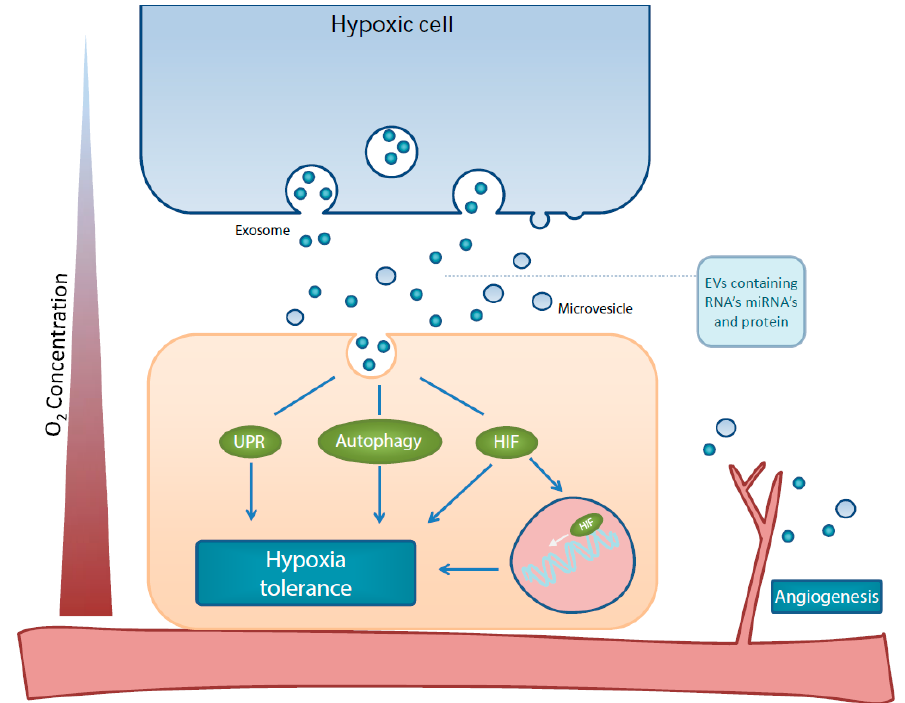
Figure 1. Schematic representation of effects by hypoxia-derived EVs on the hypoxia tolerance mechanisms, HIF, UPR, autophagy and angiogenesis.